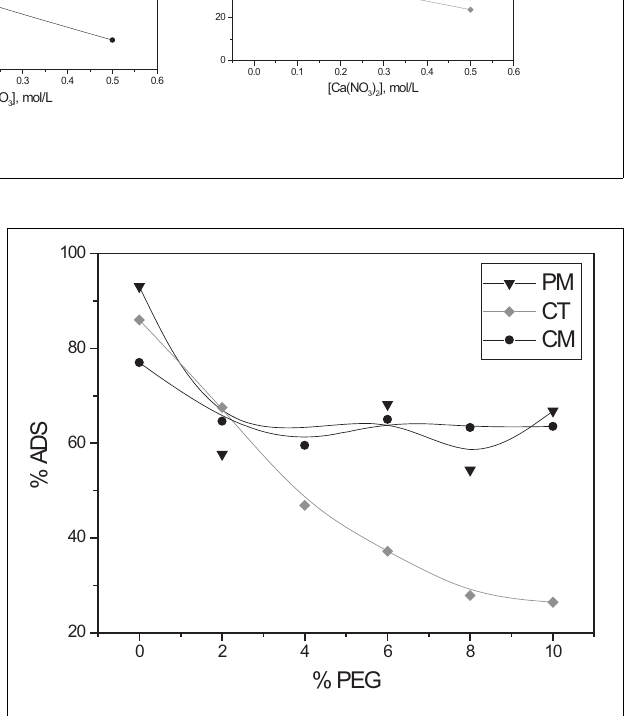
FIGURE 5 | Role of crowding agent on the adsorption of BY57 onto tea